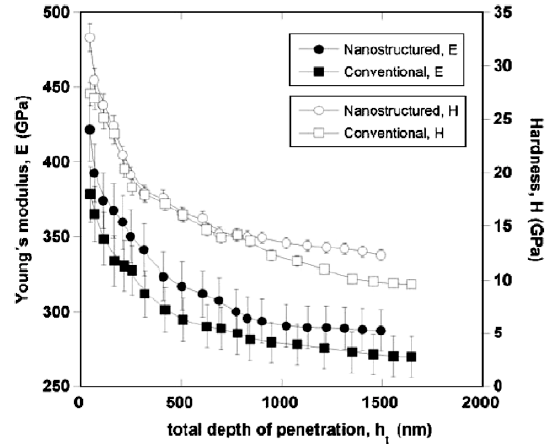
Figure 7. Young’s modulus and hardness vs. total penetration depth for both coatings [27].